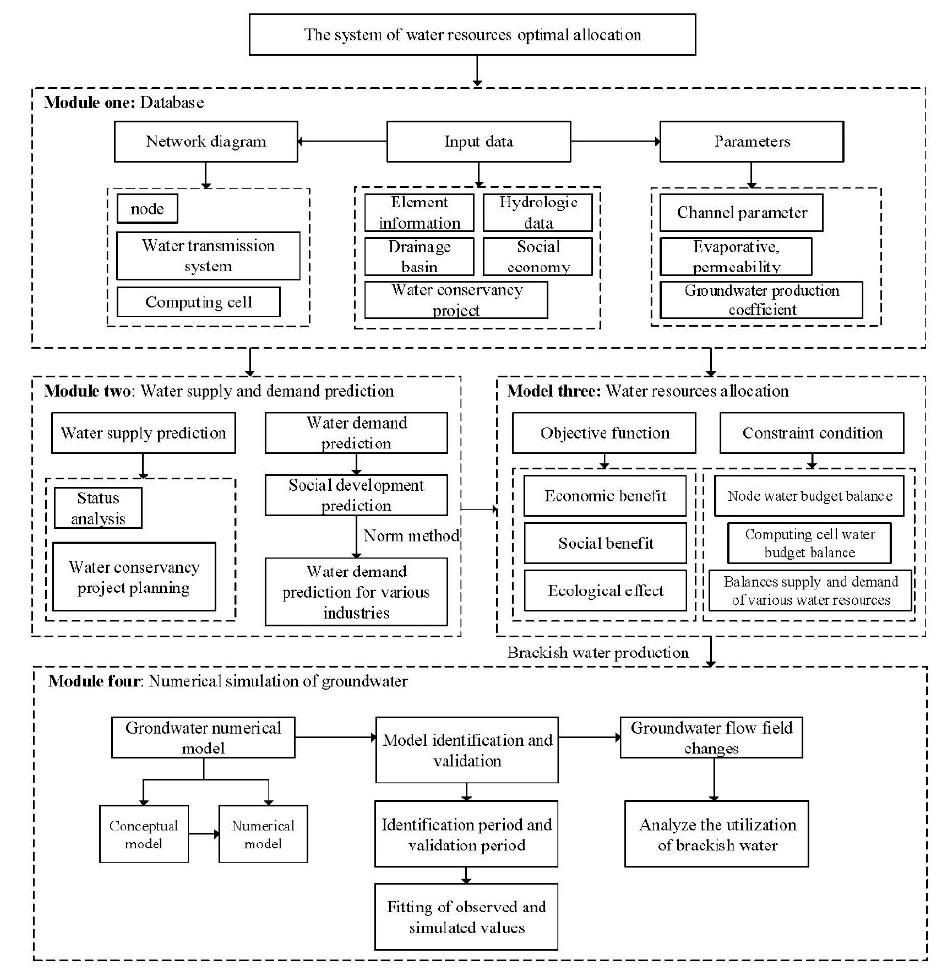
Figure 3. Working relationship of modules of optimal water resources allocation system.